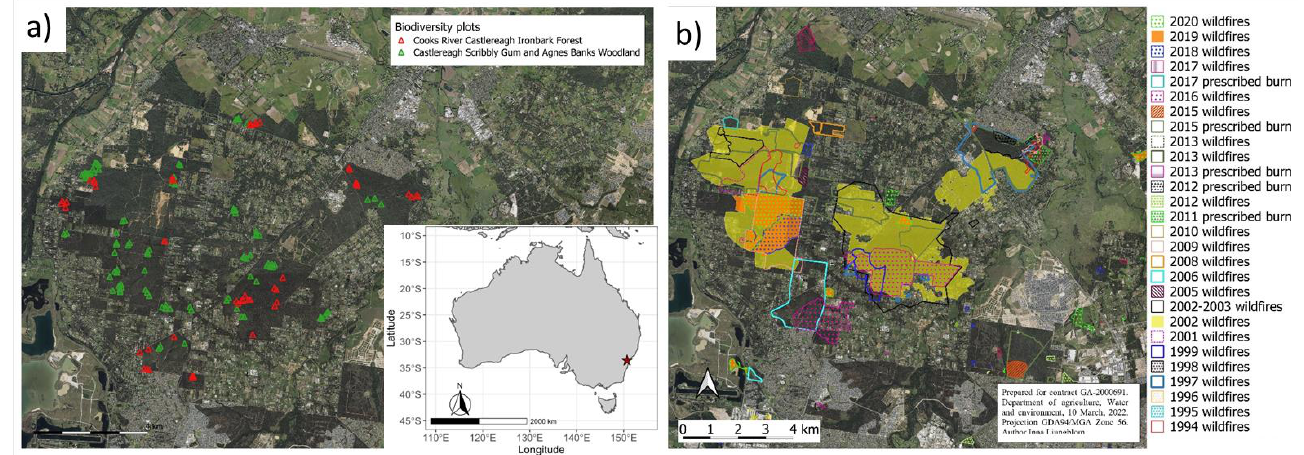
Figure 2. Study area showing ( a ) biodiversity plots and ( b ) fire boundaries, sourced from NSW Rural Fire Service and National Park and Wildlife Service. Inset shows location of study in southeast Australia.